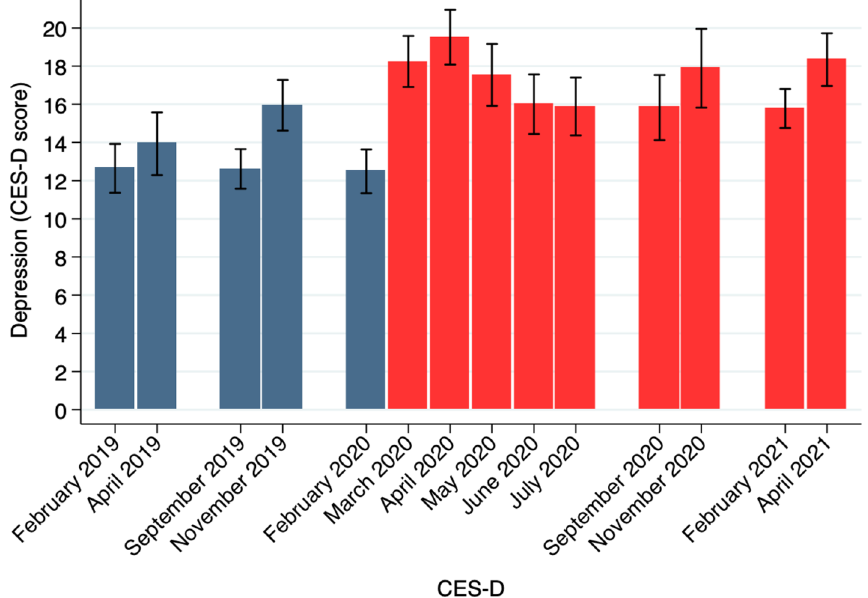
Figure 3. Depression. The figure show the average Center for Epidemiological Depression (CES-D) scale scores for the Spring 2019 through Spring 2021 terms (n = 1179). Bars indicates 95% confidence intervals. This figure was created using Stata (version 14.1) http:// www. stata.